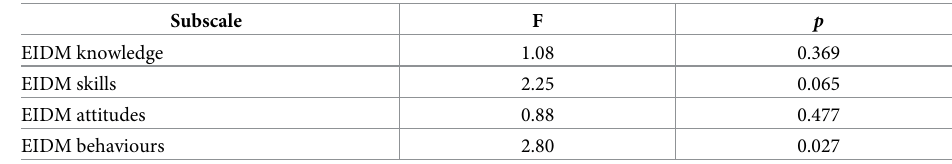
Table 7. One-Way ANOVA of EIDM subscale scores as a function of professional role.